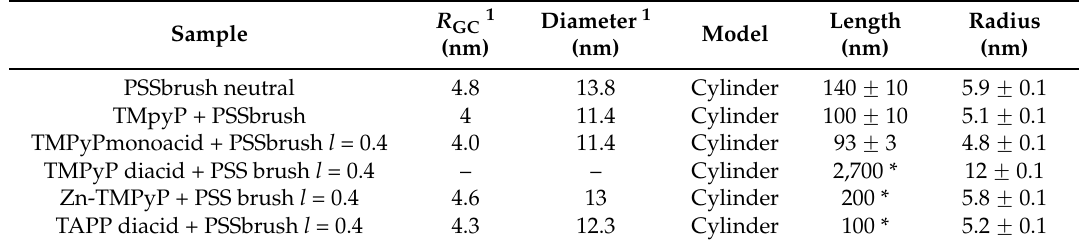
Table 1. Cylinder lengths, cross-section radii and radii from SANS